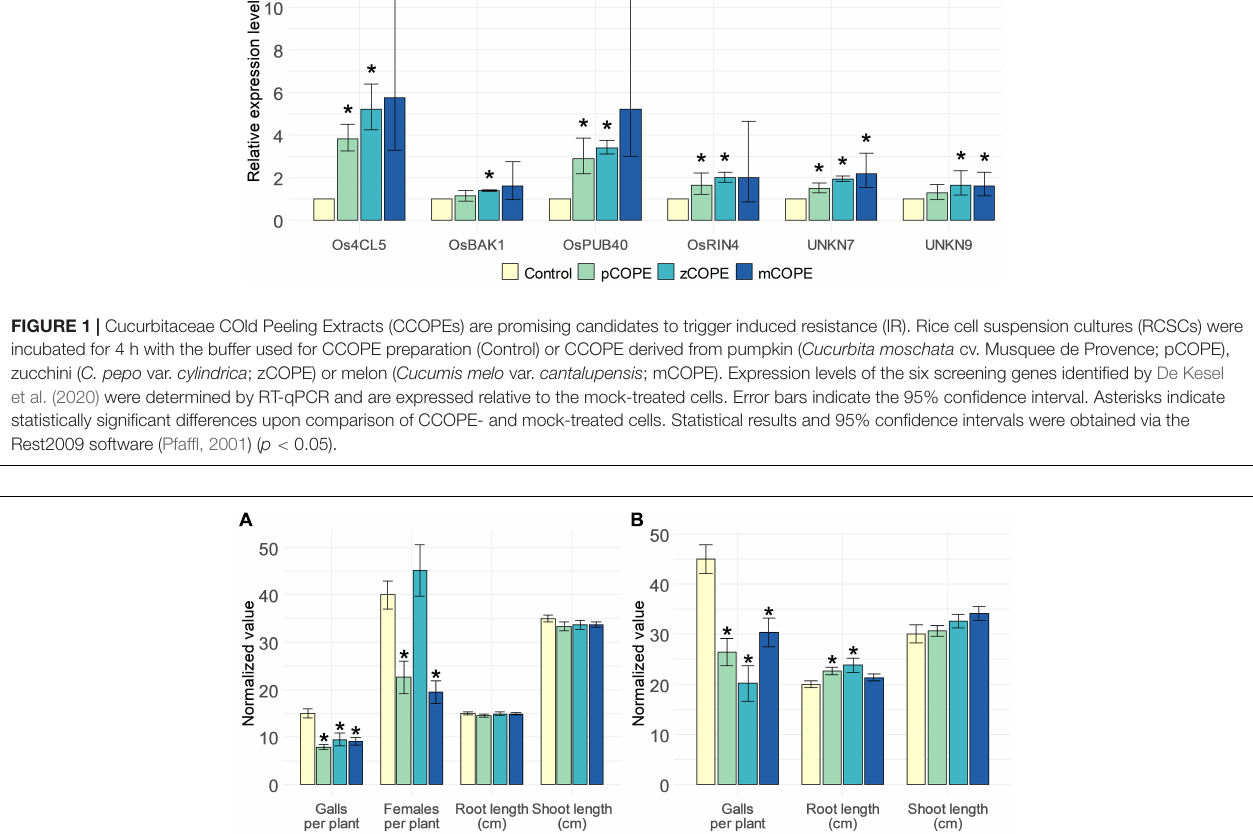
Frontiers in Plant Science |